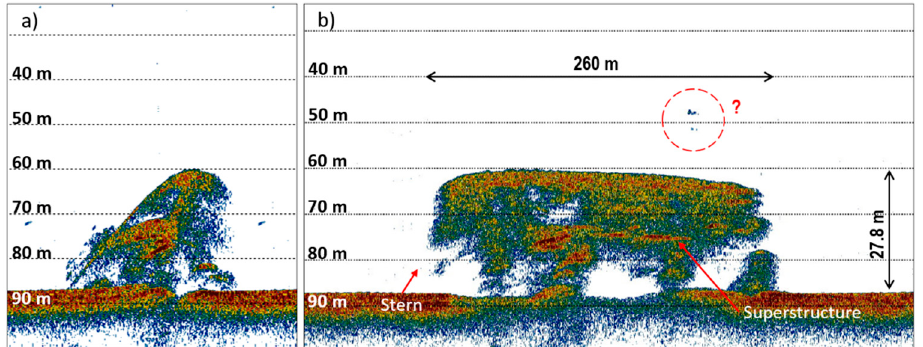
Figure 11. Single beam echo sounder data (EA-400) acquired when crossing the shipwreck ( a ) and transition along and above Graf Zeppelin ( b ).